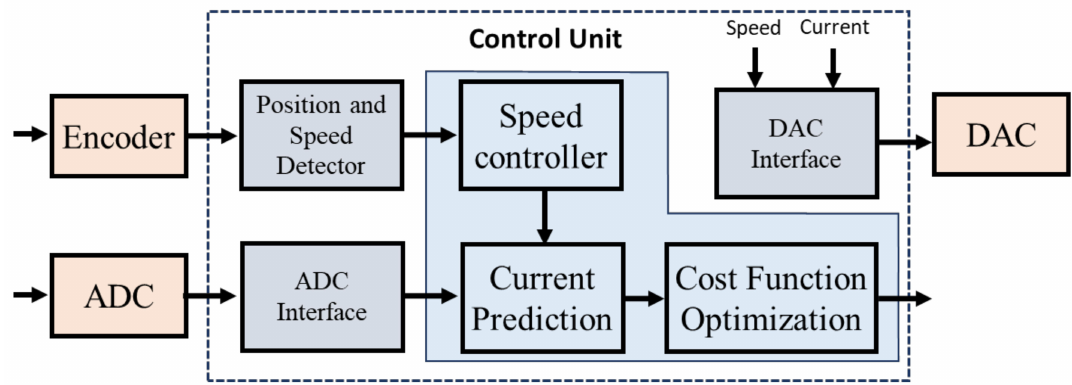
Figure 6. FPGA-based system implementation.